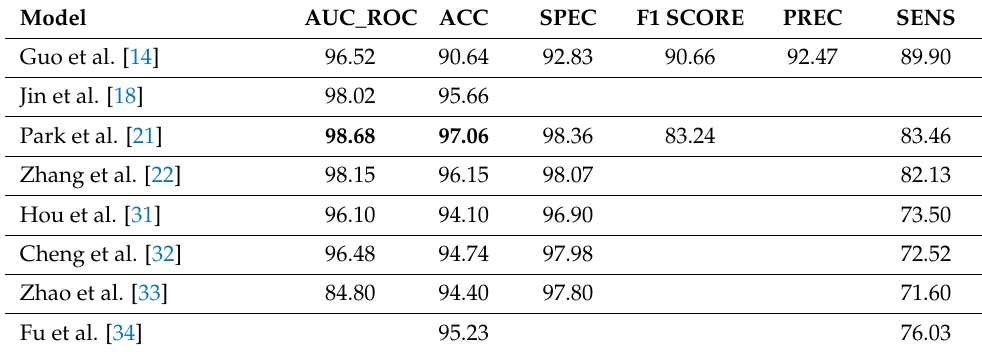
Table 1. Performance comparison of the introduced convolutional autoencoder on the DRIVE dataset.